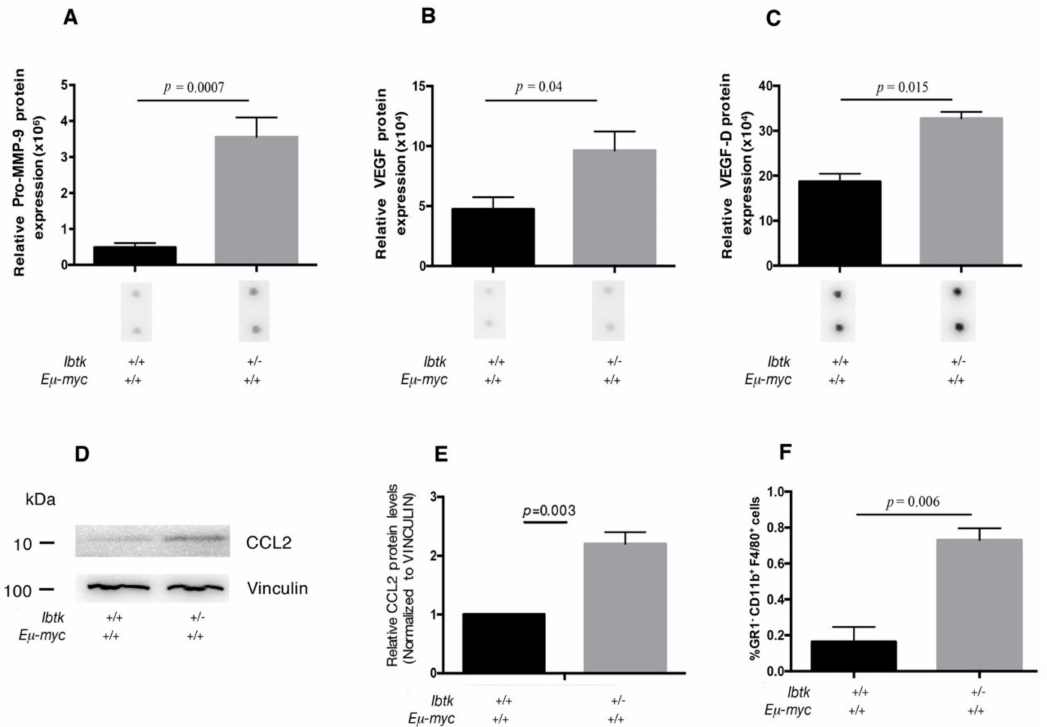
Figure 4. Cytokine expression and recruitment of tumor-associated macrophages in the tumor lymph nodes of Ibtk +/+ E µ -myc and Ibtk +/ - E µ -myc mice. A, B, C. Bar diagram showing the quantification of pro-MMP9, VEGF, and VEGF-D protein expression levels from Ibtk +/+ E µ -myc and Ibtk +/ - E µ -myc cancerous mice. Densitometry data are extracted, the background was subtracted, and the data were normalized to the positive control signals, according to the manufacturer’s protocols. Values are the mean ± SEM ( n = 3 / genotype). Representative images of individual cytokine spots are shown from identical exposures. D. Immunoblot analysis of CCL2 and vinculin expression in the protein extracts of tumor cells from Ibtk +/+ E µ -myc and Ibtk +/ - E µ -myc mice. Protein bands were normalized to the corresponding vinculin intensity. E. Bar diagram showing quantitation of CCL2 protein. Protein bands were measured by densitometry as arbitrary units and normalized to vinculin as the internal control. Values are the mean ± SEM ( n = 3 / genotype). F. Cell suspensions of tumor lymph nodes were stained with fluorescent-conjugated antibodies to reveal tumor-associated macrophages (GR1- CD11b + F4 / 80 + cells) and analyzed by flow cytometry. Values are the mean ± SEM ( n = 3 /